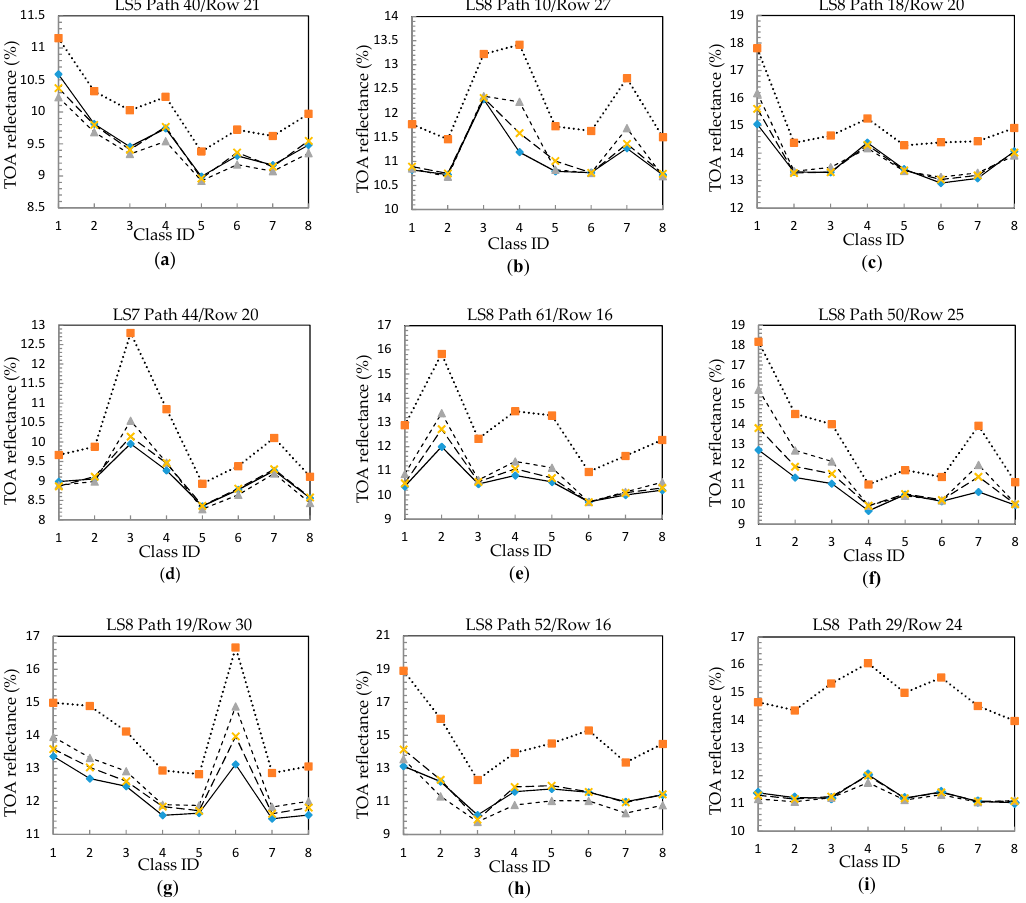
Figure 10. Comparisons of the mean values of eight classes in the first band of the nine Landsat scenes listed in Table 2. The square, diamond, cross and triangle markers represent the mean values of hazy pixels, haze-free pixels, dehazed pixels with class-based HOT radiometric adjustment (HRA) and dehazed pixels with conventional HRA, respectively.